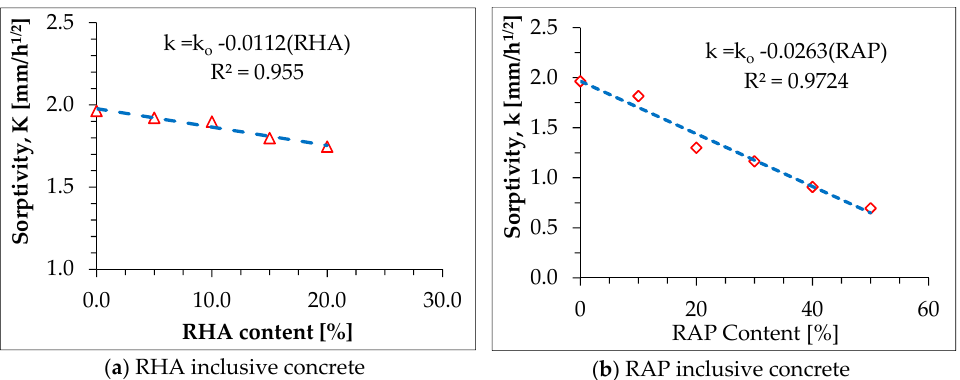
Figure 20. Relationship between sorptivity and RHA, and RAP contents.